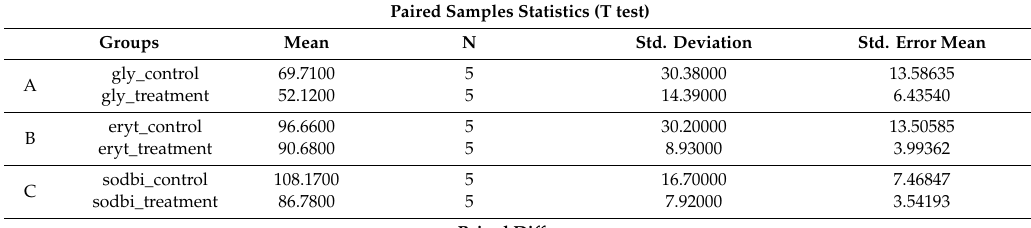
Figure 3. SEM images showing the human enamel surface alterations before and after the bicarbonate powder use (group C). The images show numerous enamel irregularities: ( A ) 23 × magnification image of non-treated half part of tooth; ( B , magnification of A1 in A ) higher magnification (10,000 × ) of non-treated enamel. Pronounced depressions were present on enamel specimens. Meanwhile, the ( C ) 23 × and ( D , magnification of C1 in C ) 10,000 × demonstrate the enamel surface after treatment showing a reduction of enamel irregularities. Irregularities were also present but the major reduction was calculated on the specimens treated with this powder ( p < 0.05). Table 1. Surface roughness ( R q ) measurements in control and treatment samples. Samples showed a statistically significant di ff erence only in group C (sodium bicarbonate) ( p < 0.05). Paired t-test was performed to verify the significance of the di ff erence between